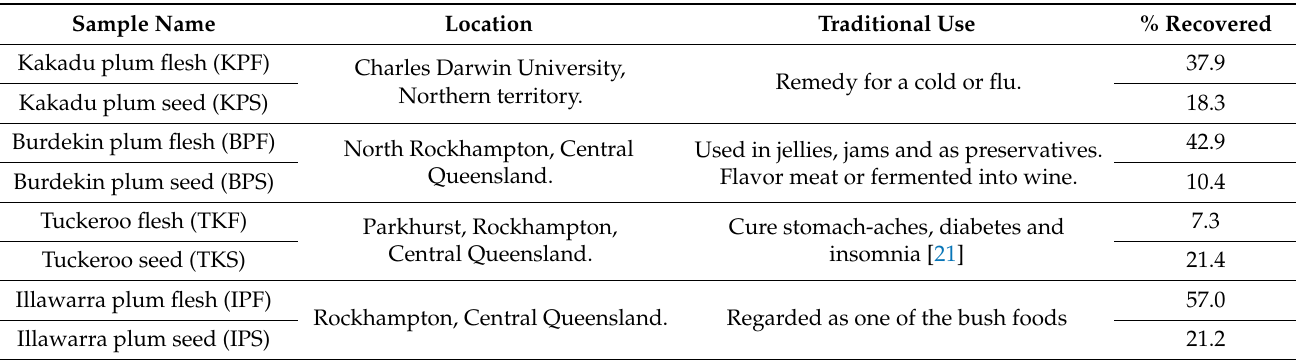
Table 5. Percentage yield of crude crystal product.